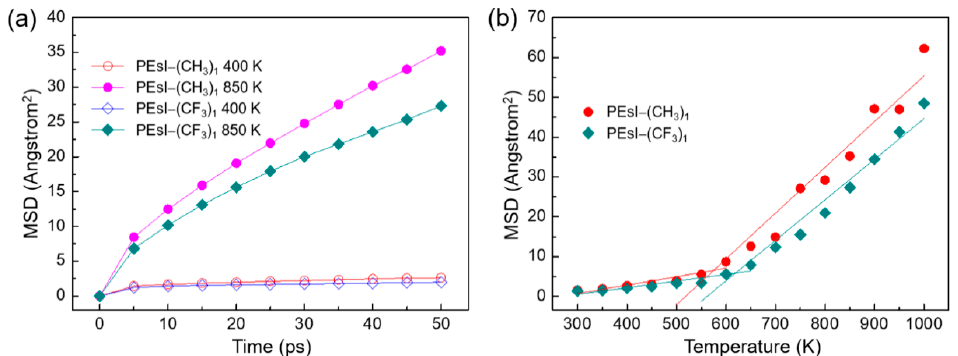
Figure 5. ( a ) Mean-square displacement (MSD) curves as a function of time for PEsI–(CH 3 ) 1 and PEsI–(CF 3 ) 1 at 400 and 850 K. ( b ) MSD curves as a function of temperature at 50-ps time intervals for the unit cells of the PEsI–(CH 3 ) 1 and PEsI–(CF 3 ) 1 systems.